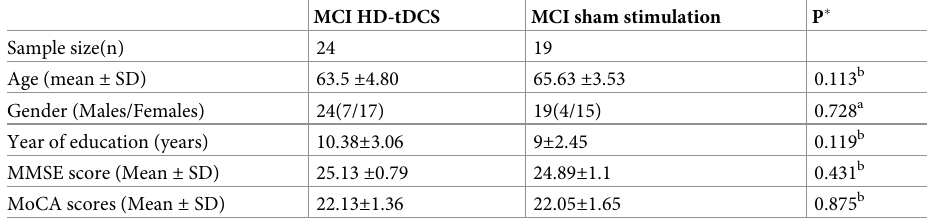
Table 1. Demographic and neuropsychological data.